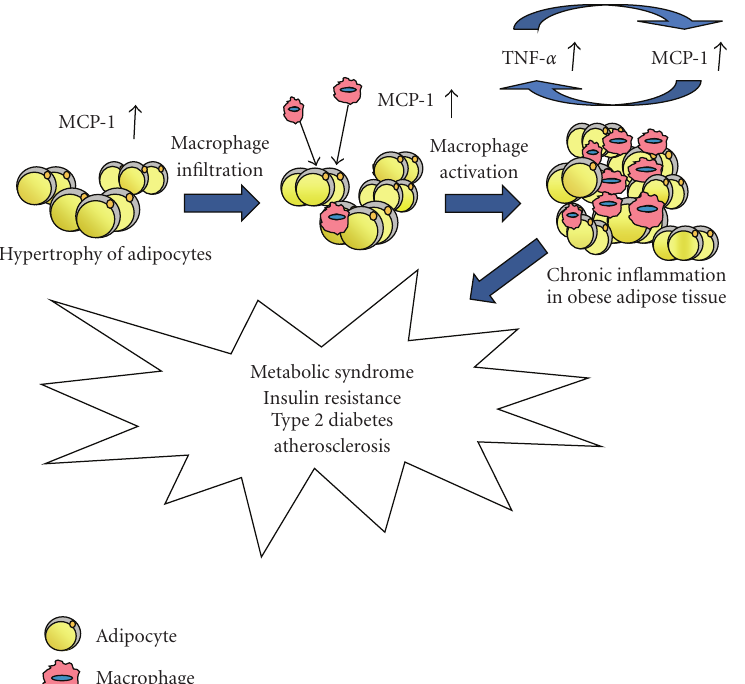
Figure 1: The development of vicious cycle of inflammation between adipocytes and macrophages in obese adipose tissue.